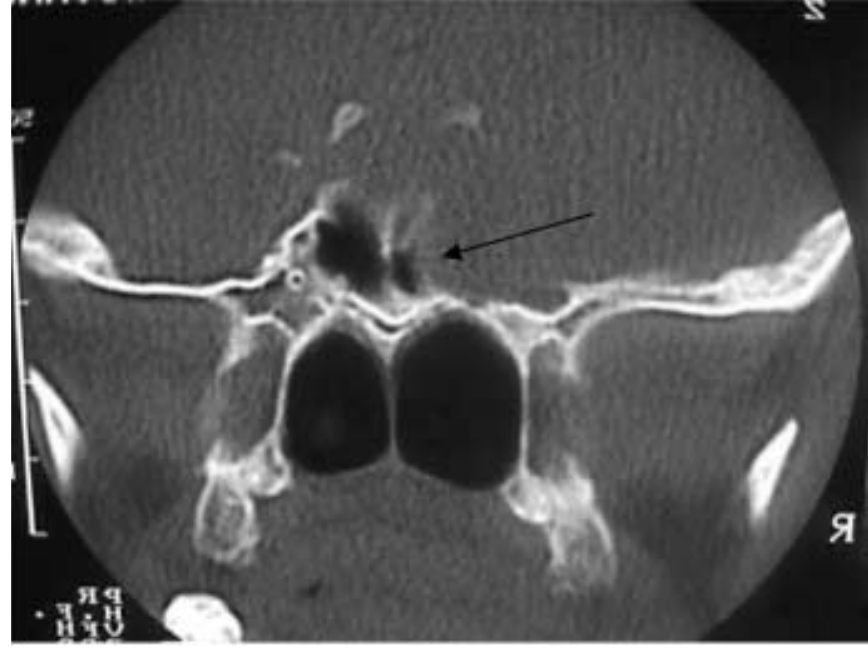
Suprasellar arachnoid cyst (black arrow) destructing the sphenoid